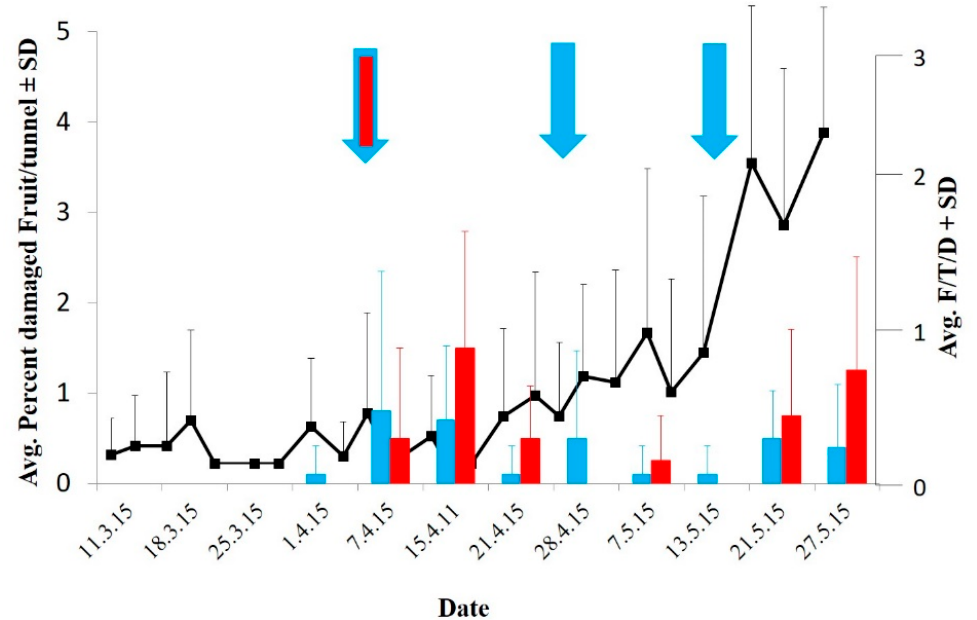
Figure 10. Average flies/trap/date (black line) during the spring of 2015 in the southern melon growing site of Ein Yahav, and percent infested fruit in DSS-managed (red bars) and calendar-spraying managed (blue bars) melon producing greenhouses. The dates of pesticide spraying are shown for both calendar-spraying management (blue arrow) and DSS-managed greenhouses (red strip inside blue arrows).